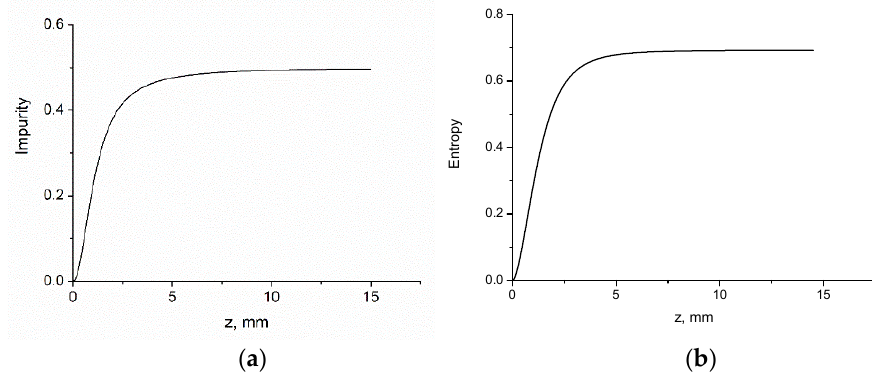
Figure 2. ( a ) Impurity as function of distance. ( b ) Entropy as function of distance. 𝑎 (cid:2868) = 15 μm .